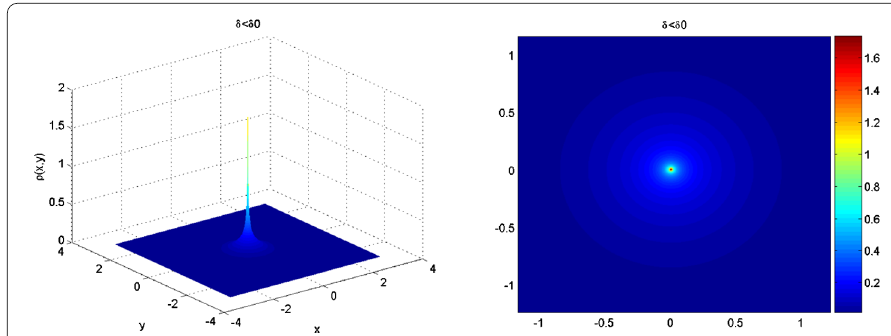
Figure 4 Portraits of (cid:21) ( x , y ) (left) and distribution of invariant densities (right) when A = 1, B = 1.88, δ = 0.3898979486 < 0.4898979486 = δ 0